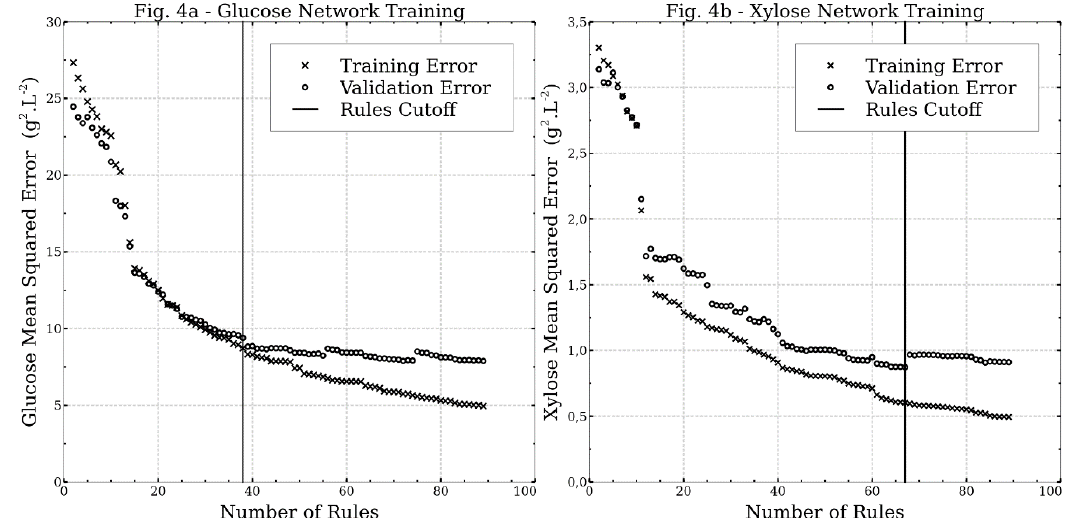
Figure 4. Error dispersion for Artificial Neural Network (ANN) number of rule optimization with smoothing parameter 0.4. ( a ) Glucose network error dispersion; and, ( b ) Xylose network error dispersion; crosses represent training mean squared error (20% of data) and circles training mean squared errors (80% of data); solid vertical line is the optimum number of rules. Processes 2019 , 7 , x FOR PEER REVIEW 12 of 19